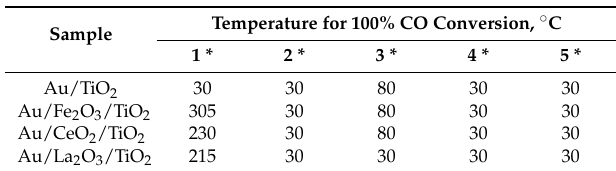
Table 1. Temperature of 100% CO conversion for different catalyst states as a function on the nature of support modifying